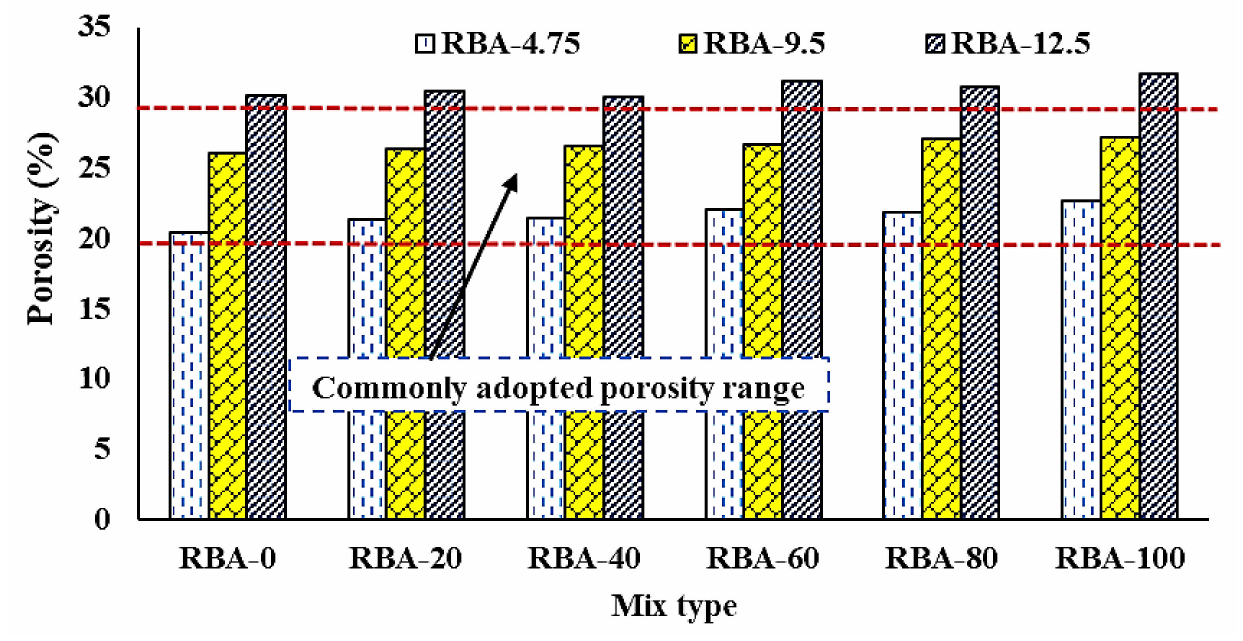
Figure 6. Variation of porosity in PC